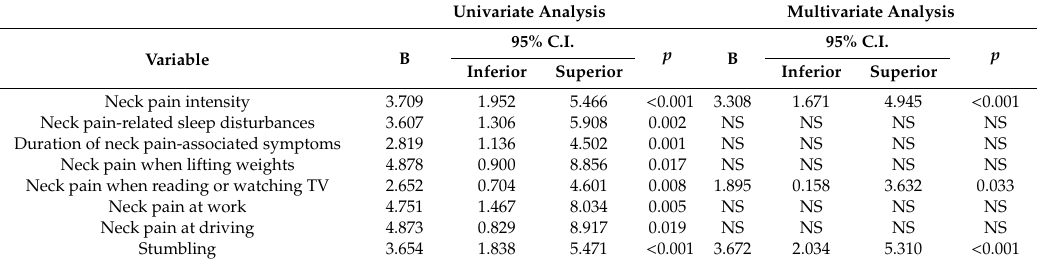
Table 3. Univariate and multivariate lineal regression to analyze the factors related to headache-related disability.